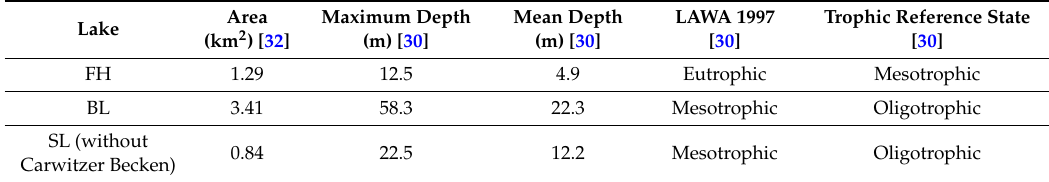
Table 1. Overview of morphology and limnological characteristics of the lakes FH, BL, and SL. The limnological characterization is based on the Bund/Länder-Arbeitsgemeinschaft Wasser (LAWA) trophic index.